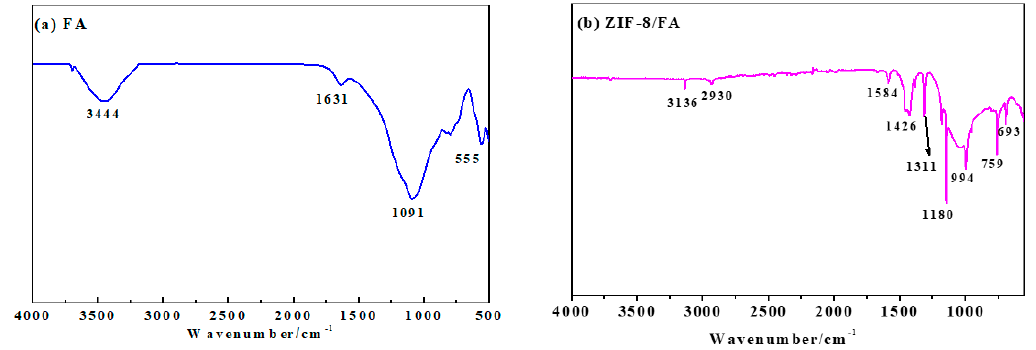
Figure 3. Fourier transform infrared (FTIR) spectra of ( a ) FA and ( b ) prepared ZIF-8/FA composite powders.